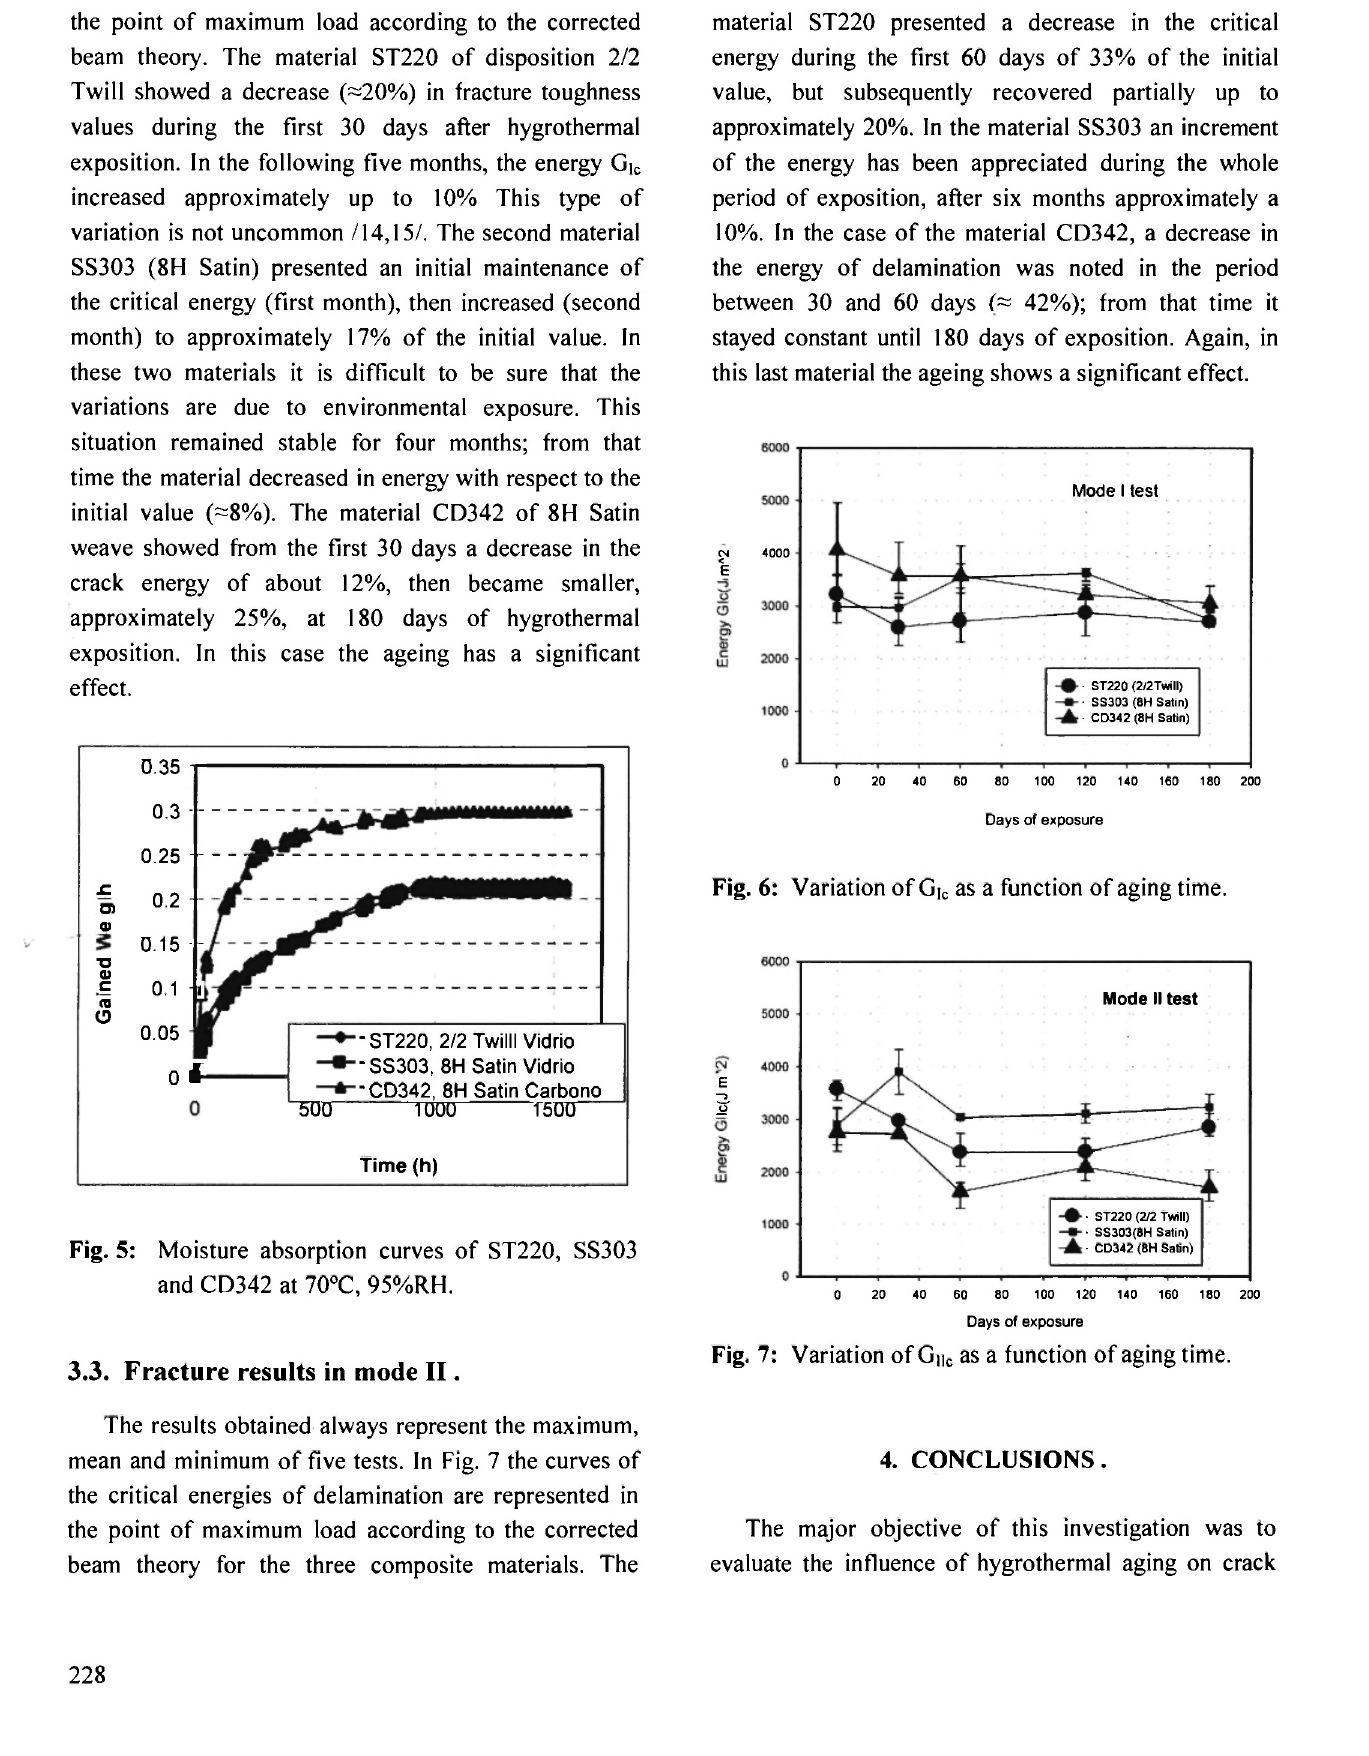
7: Variation of Gn c as a function of aging